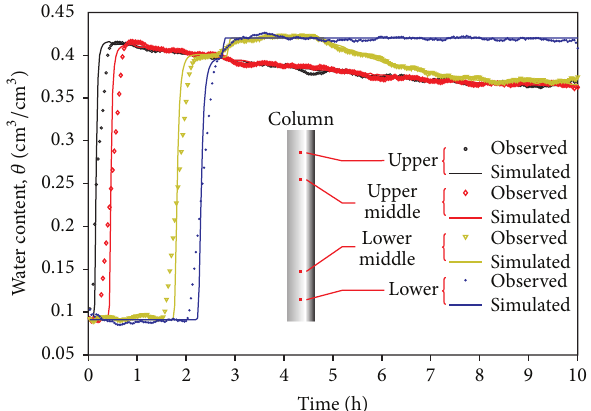
Figure 8: Performance comparison between the water content observed in the electrical resistivity probes and the water content simulated by Hydrus-1D model. The results correspond to the third infiltration test for a time period of ten